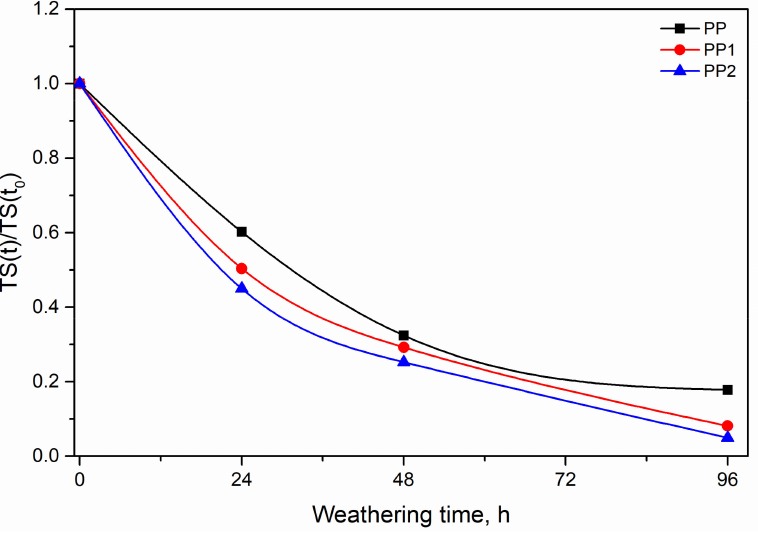
Figure 11. Relative tensile strength as a function of the weathering